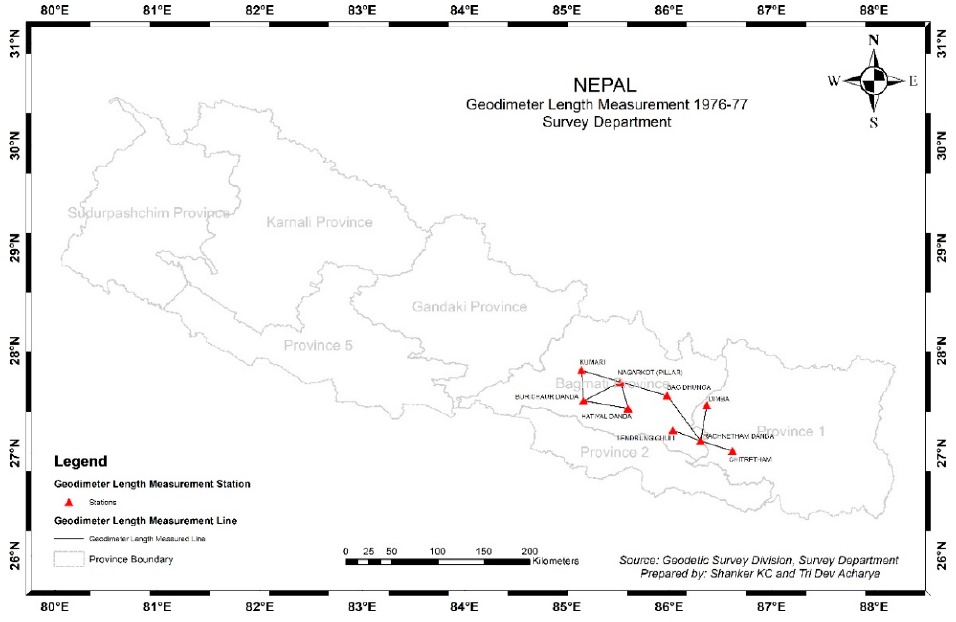
Figure 6. Geodimeter length measurement in 1975–1976.